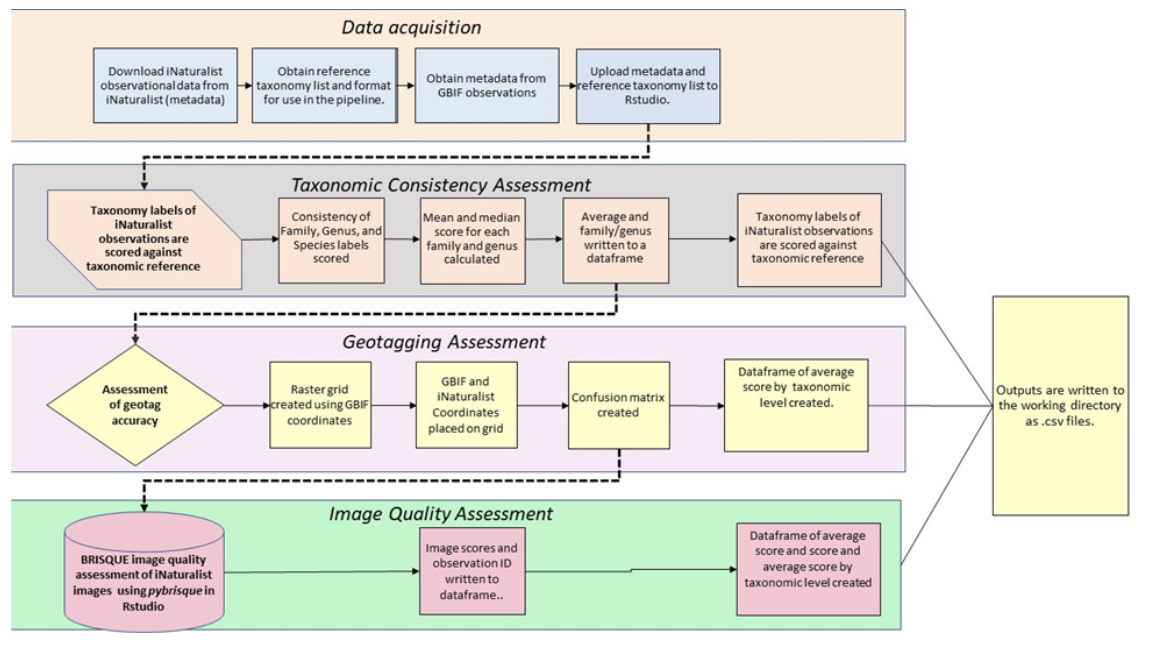
Figure 1. Workflow for pipeline suite. Data is acquired from iNaturalist and GBIF. The first pipeline compares the taxonomic consistency of the iNaturalist data. The second assesses the quality of the images using pyBRISQUE, and the third compares the geo-tagging from the iNaturalist observations to those obtained by GBIF. Bold dashed lines represent transitions between pipelines in the suite of pipelines. Data frames and assigned variables will be passed between pipelines. All outputs are saved to the working directory as .csv